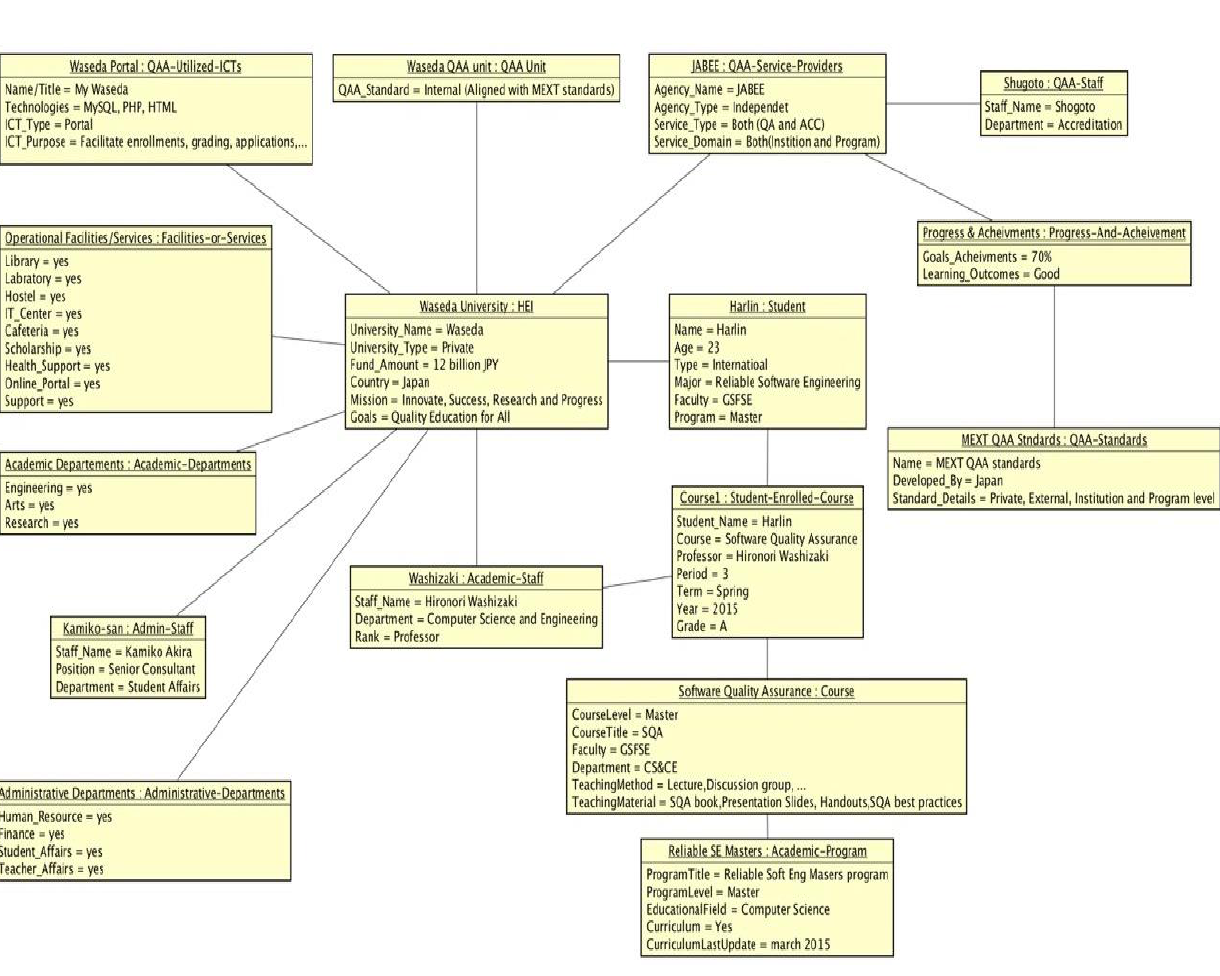
Figure 4 . Object diagram for the conceptual model